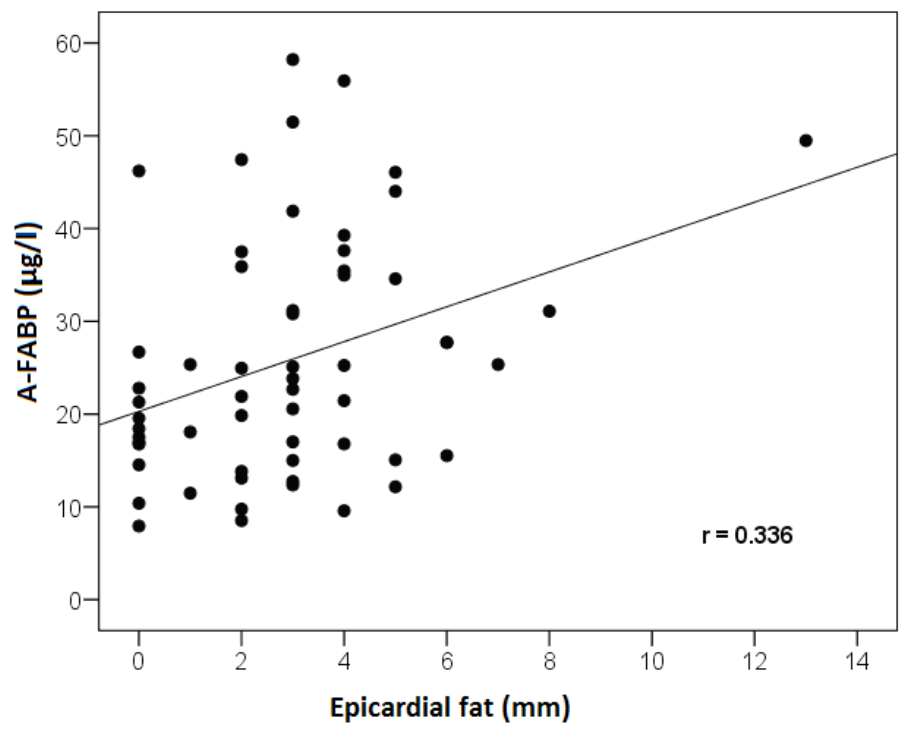
Fig. 1. Possitive correlation between amount of epicardial fat and A-FABP level was found. (r=0.336; P